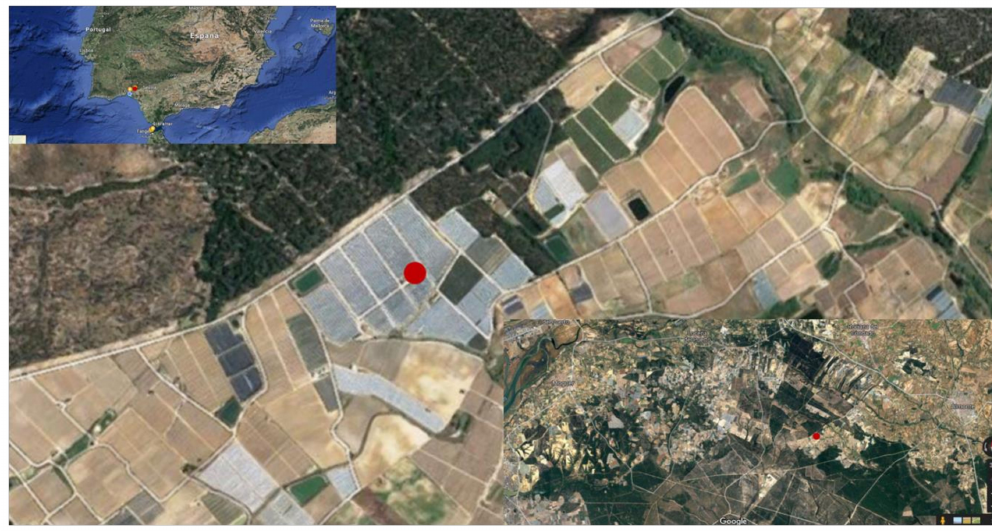
Figure 6. Experimental site for the field test.